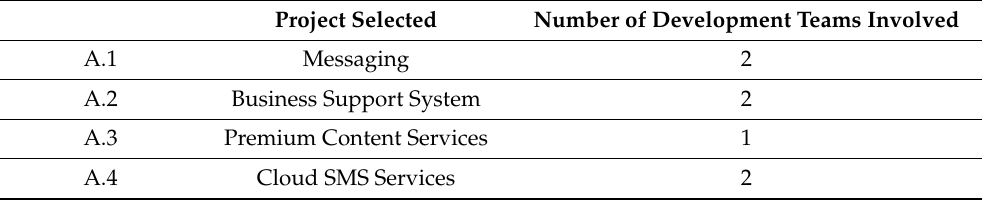
Table 1. Projects selected in A.